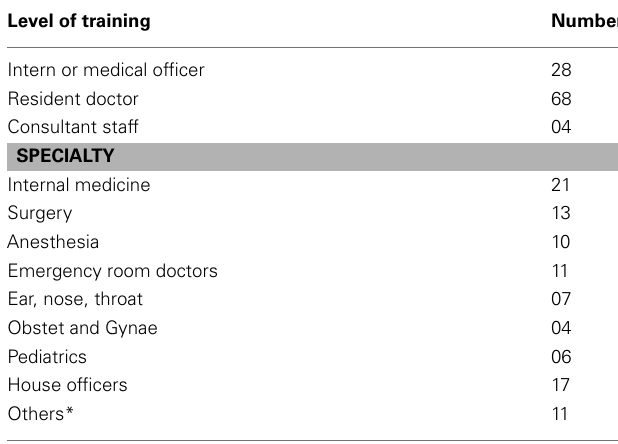
FIGURE 1 | Proportions of correct identification of the components of each clinical variable of the GCS by all the study participants.